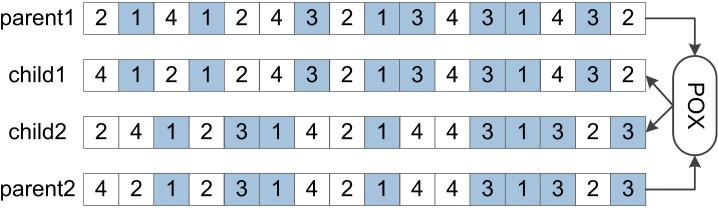
Principles of POX.